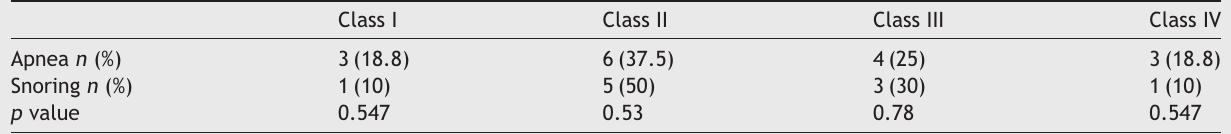
Comparison between apnea and snoring groups according to modified Mallampati classification.